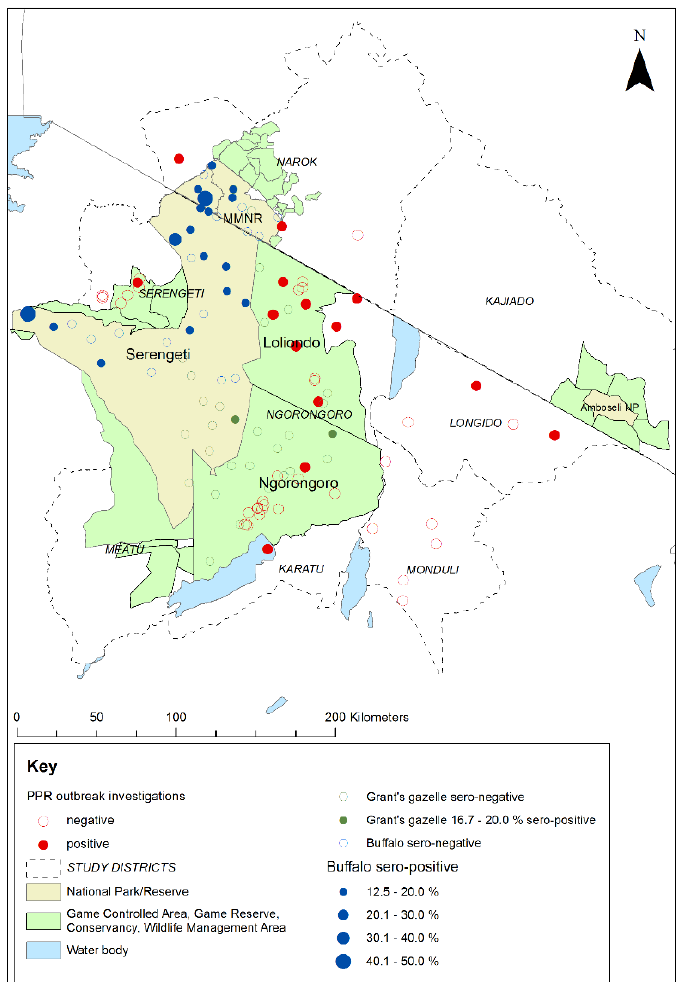
Figure 9. Map of the Greater Serengeti and Amboseli ecosystems showing locations of peste des petits ruminants virus (PPRV) positive and negative investigations of PPR-like disease reports in sheep and goat flocks, in relation to the 2018–2019 cross-sectional survey sampling sites and PPRV seroprevalence for African buffalo and Grant’s gazelle. Positive disease investigations were defined as at least one animal positive by PPRV rapid detection test and/or real-time reverse transcription-polymerase chain reaction.